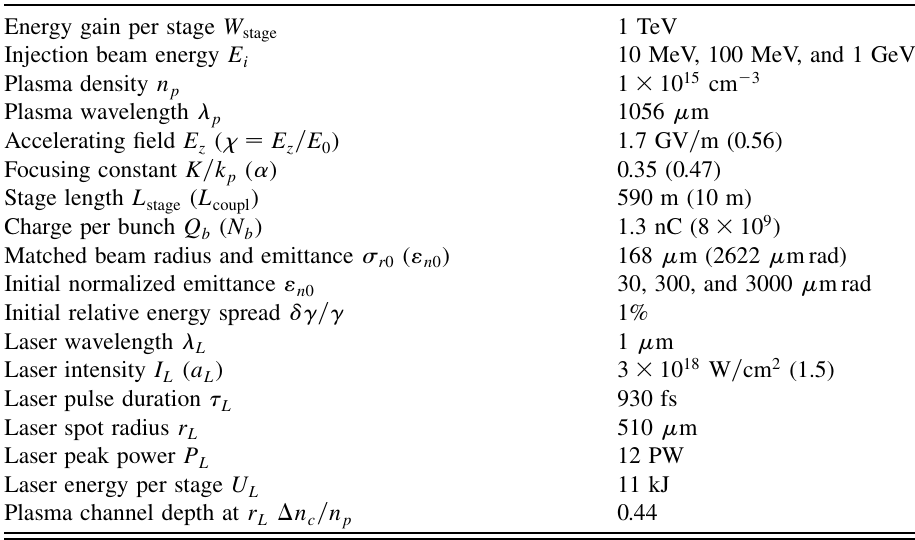
TABLE I. Example parameters of a 1 TeV laser-plasma accelerator